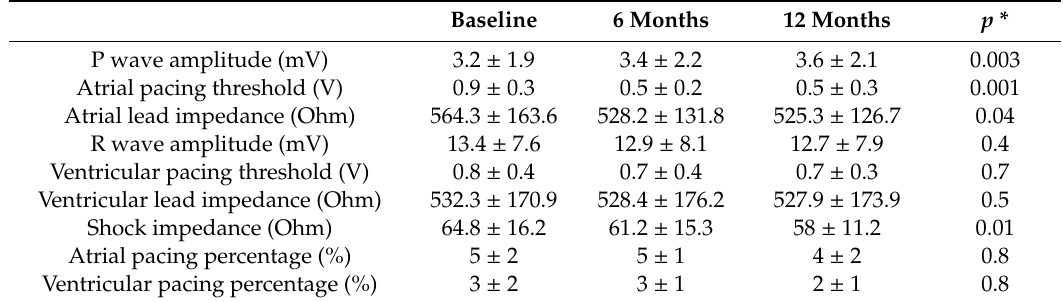
Table 5. Electrical parameter values at baseline and over time in the overall study